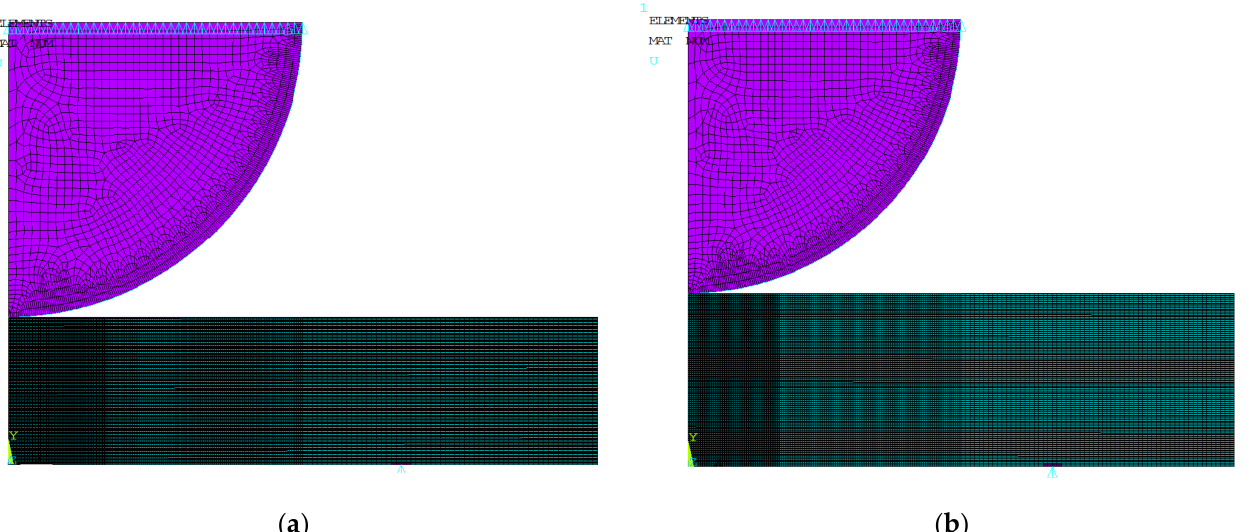
Figure 5. Finite element mesh for a 1.5 mm thick disk specimen made of 12Cr F/M steel irradiated at 390 °C ( a ) and 1.9 mm thick disk specimen made of 12Cr F/M steel irradiated at 550 °C ( b ).